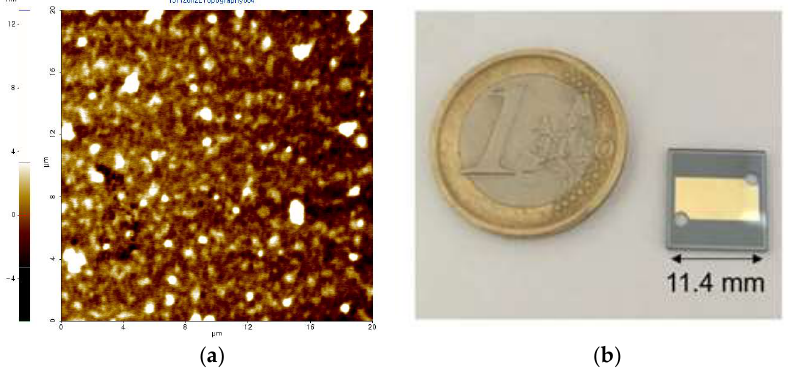
Figure 6. Fabrication results ( a ) surface roughness of the metal film; ( b ) SPR chip with multiple air-gaps.